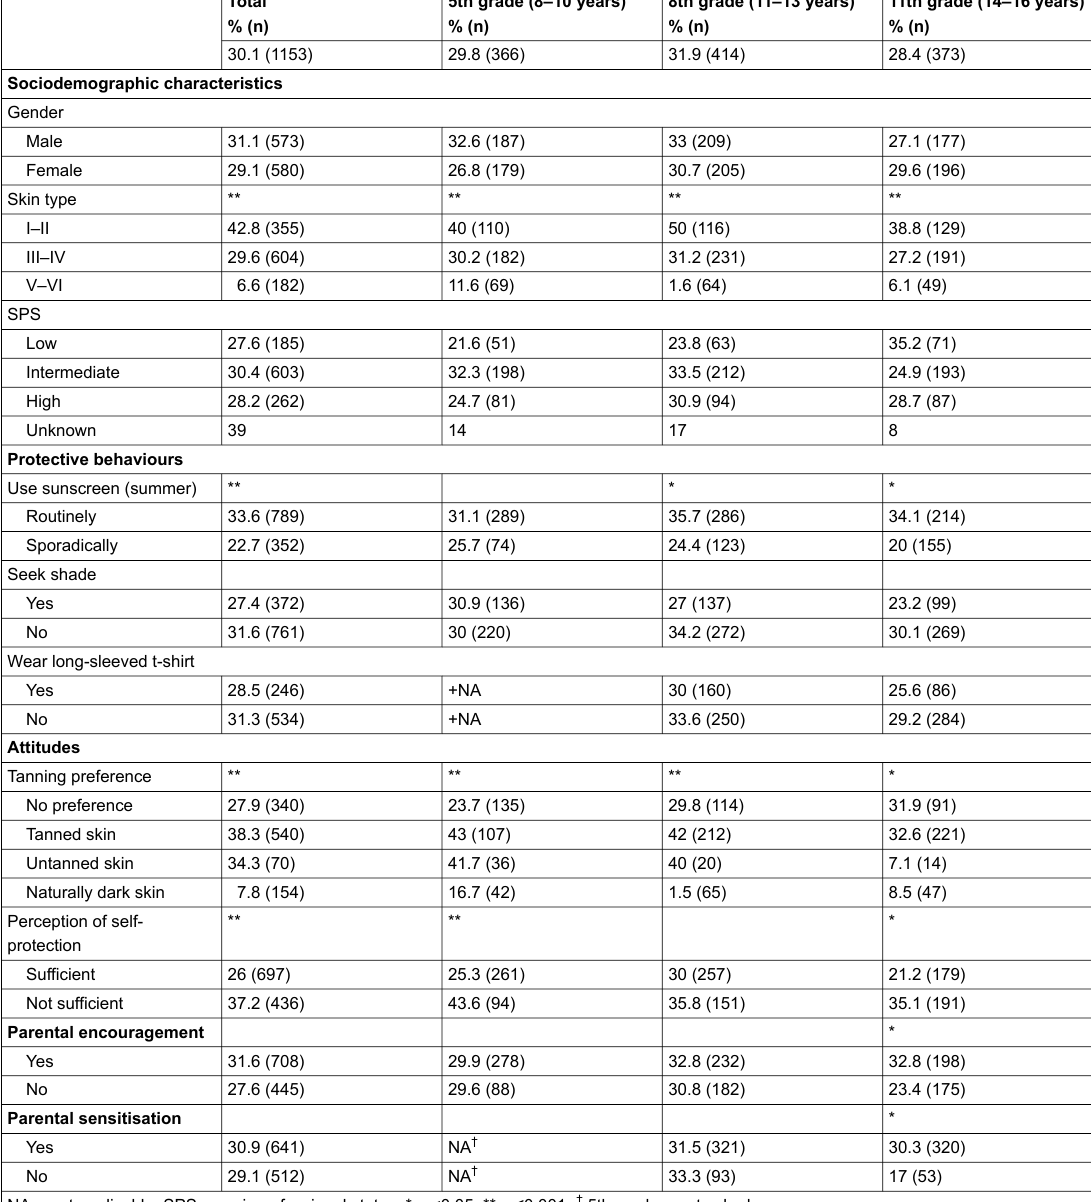
Table 2: Prevalence (in %) of at least two sunburns by school